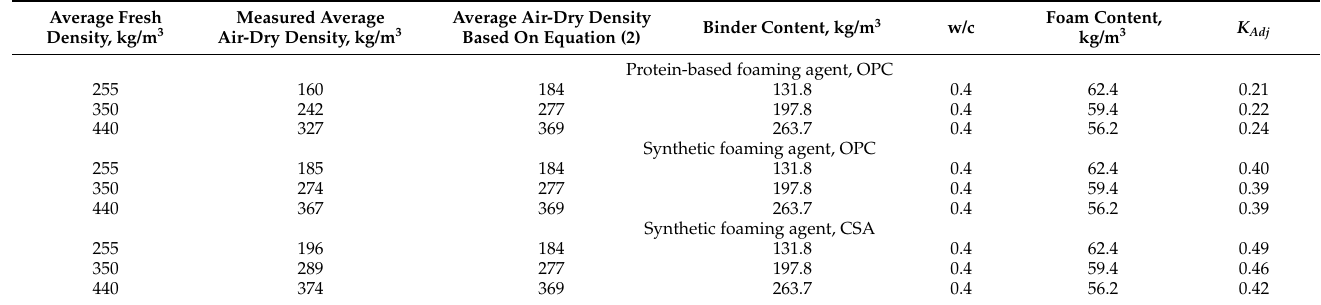
Table 5. Estimation of the K Adj -adjusted coefficient for air-dry curing (Equation (1)). Average Fresh Measured Average Average Air-Dry Density Air-Dry Density, kg/m 3 Based On Equation Density, kg/m 3